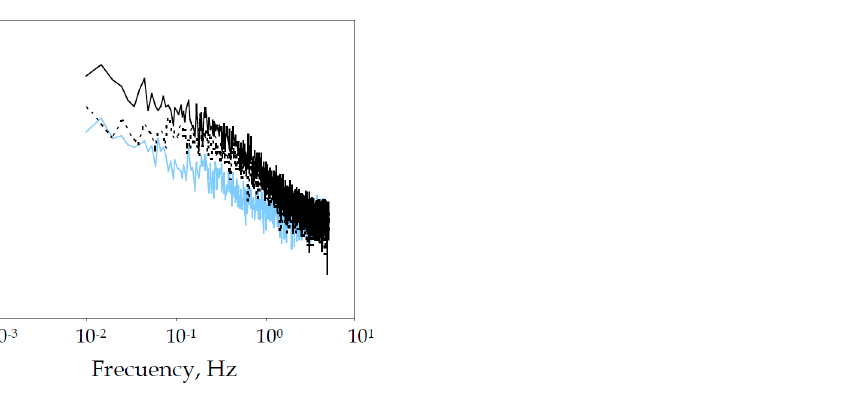
Figure 8. Energy density spectra at outer window side at the north side window (Test 1). Spectra of u x ( ▬ ), u y ( ▬ ), and u z ( ).